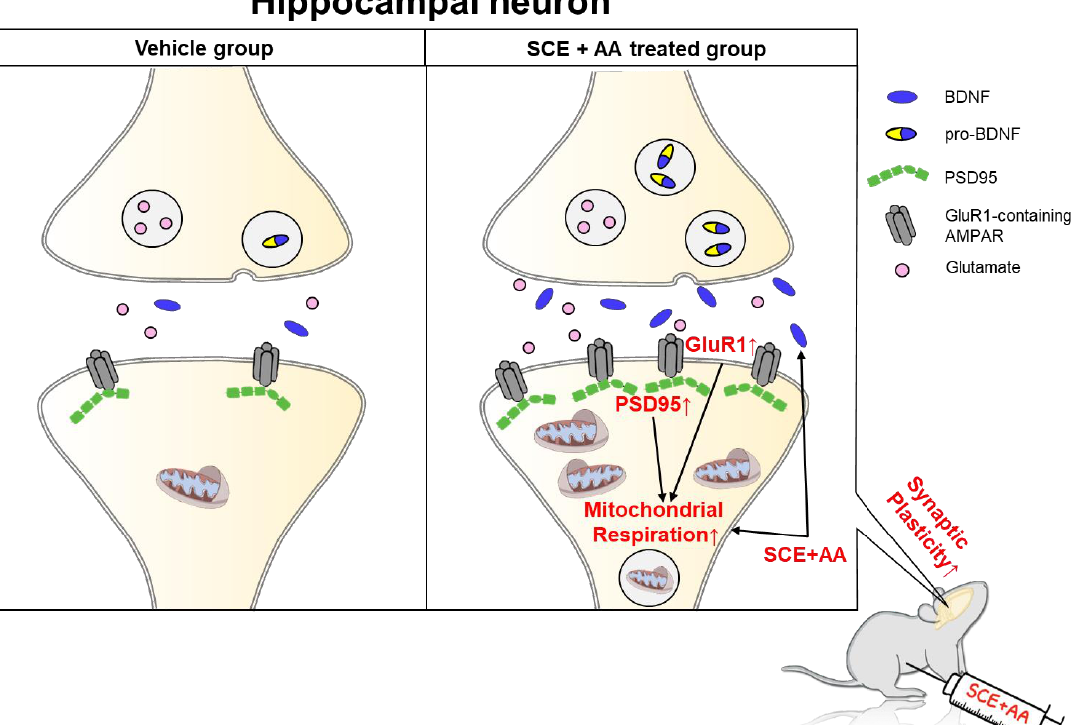
Figure 5. Schematic representation of the effects of an SCE-AA mixture on mitochondrial respiration and synaptic molecule expression in the hippocampus. BDNF, secreted from presynaptic or postsynaptic neurons, astrocytes, or microglia into the synapse, binds to the TrkB receptor and activates signaling cascades responsible for neuronal survival and synaptic plasticity. Our findings suggest that SCE-AA mixture-induced increases in adenosine triphosphate (ATP) production through mitochondrial respiration possibly enhance dendritic spine formation and synaptic plasticity, thereby improving learning and memory storage. The BDNF gene is transcribed in the cytosol in a pro-form and is secreted into the synapse in the activated BDNF form. An SCE-AA mixture induces BDNF expression, leading to reinforcement of synaptic plasticity through increased mitochondrial respiration and upregulation of PSD95.